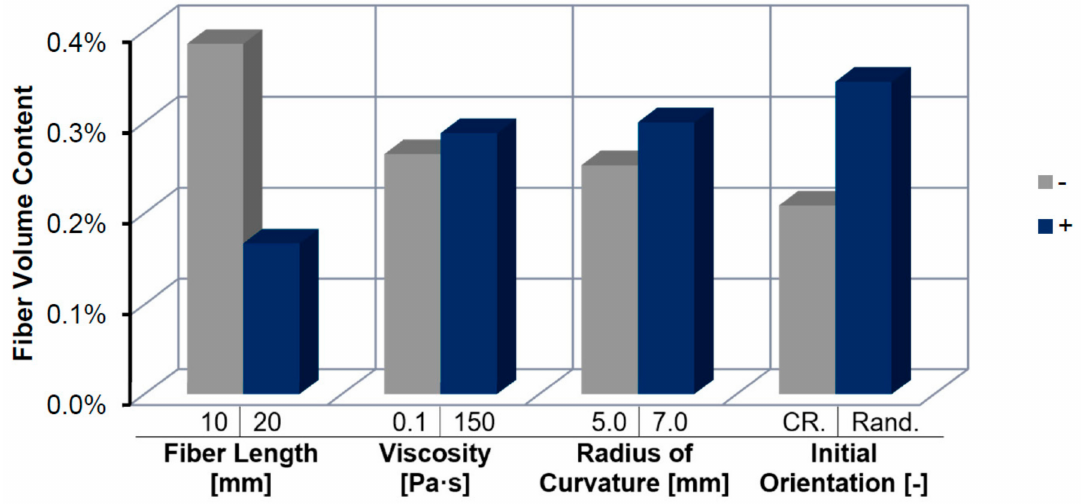
Figure 9. Average effect on volume fraction in middle section of